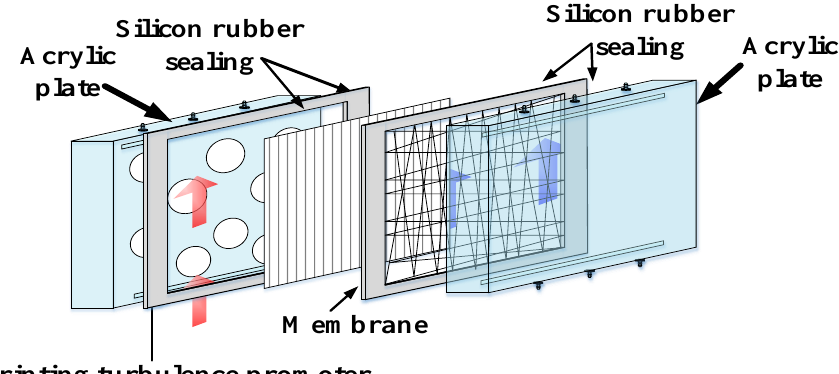
Figure 1. Schematic diagram of the experimental setup for the direct contact membrane distillation (DCMD) system.